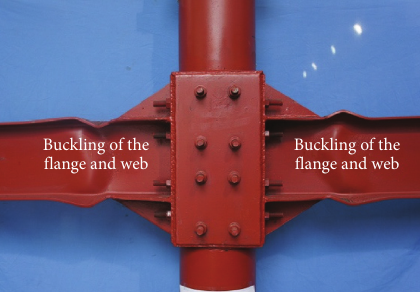
Figure 11: Failure modes of